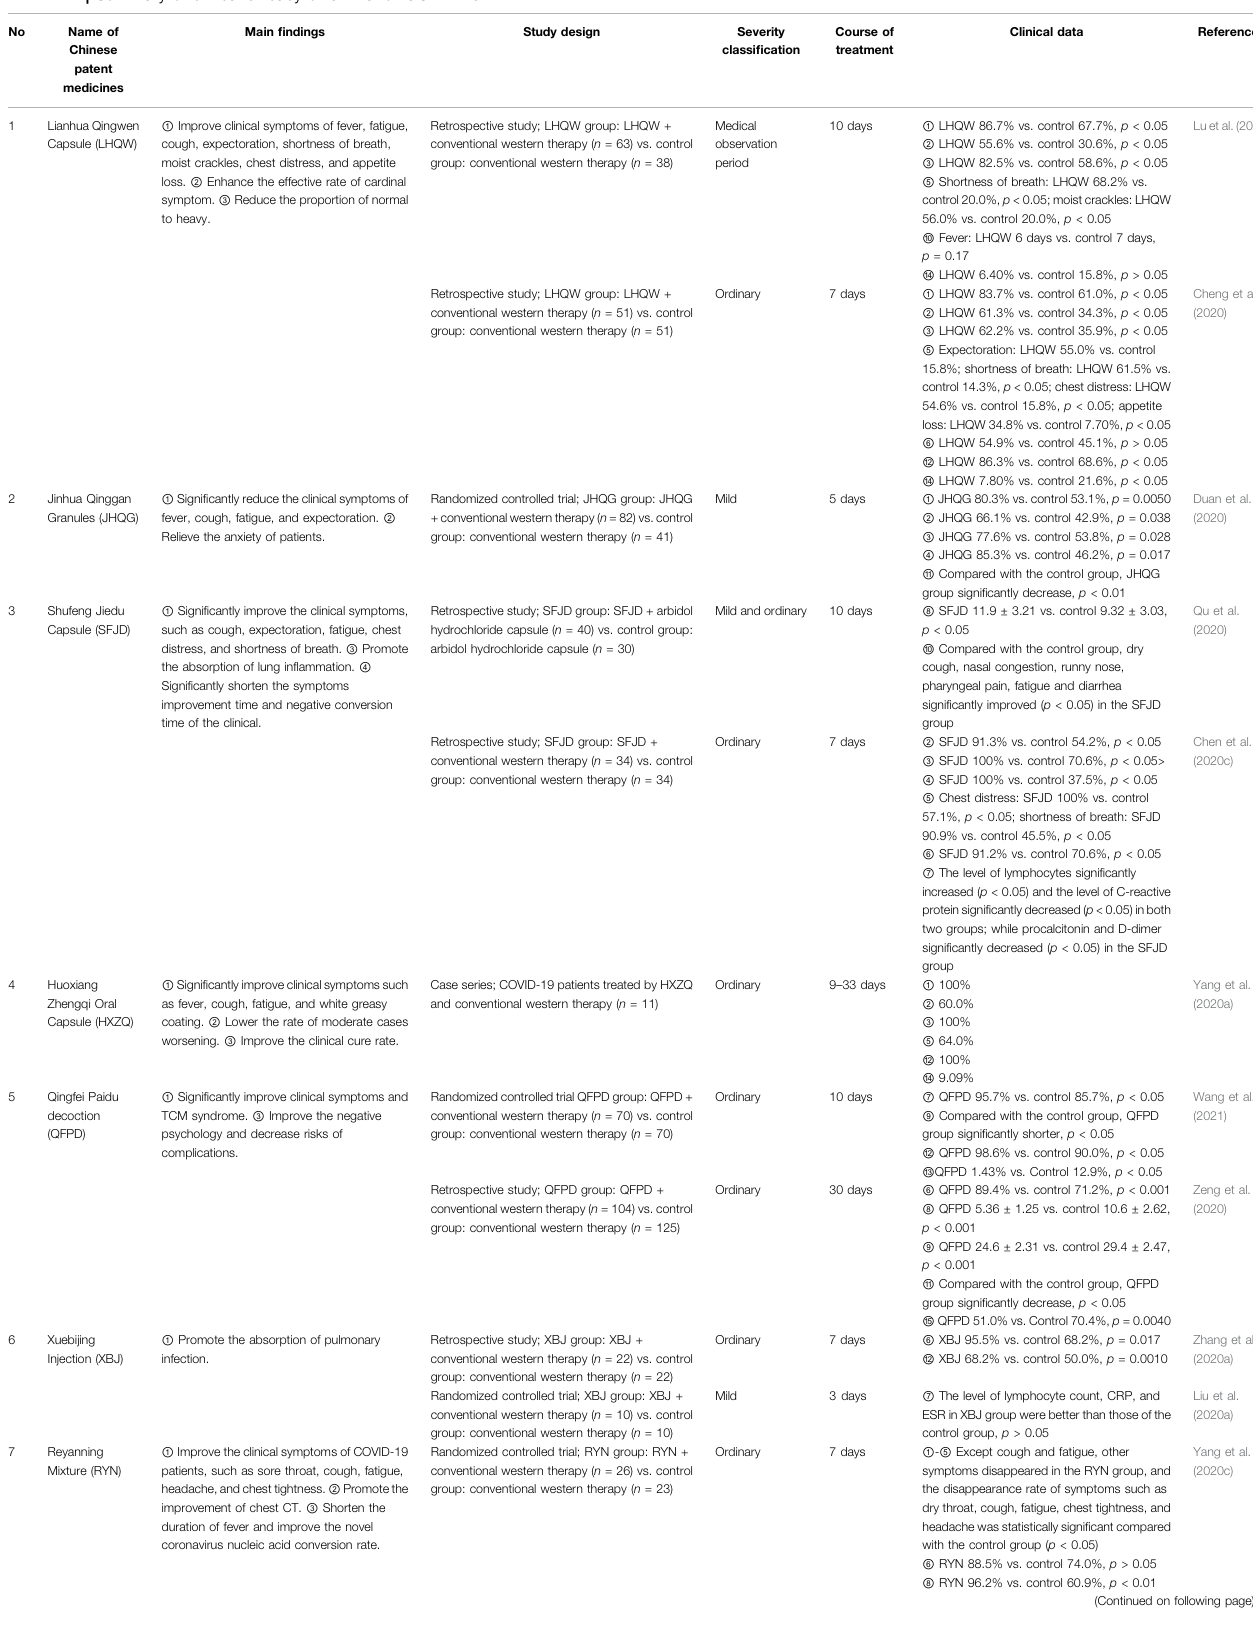
TABLE 2 | Summary of clinical ef fi cacy of CPMs for COVID-19.